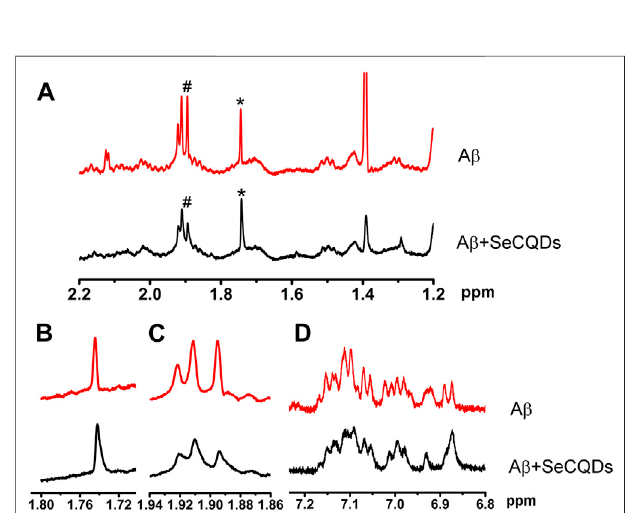
FIGURE 5 | 1 H NMR spectra of A β before and after incubated with SeCQDs.ThesignalsofamideprotonsofLys16(thepeaksmarkedwith*)and the resonances from the protons of Glu (the peaks marked with #) were restored upon co-incubation of SeCQDs with A β (A) . Locally ampli fi ed 1 H NMR spectracentered at 1.74 ppm (B) . Locallyampli fi ed 1 HNMR spectra centeredat1.91 ppm (C) .Thechangesoftheresonancesfromtheprotonsof Tyr10, Phe19 and Phe20 (D)